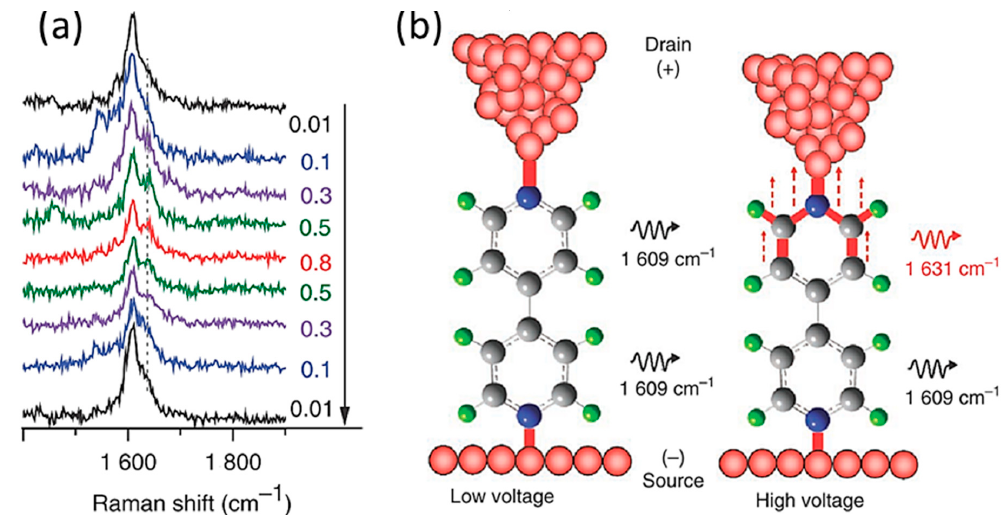
Figure 9. ( a ) The bias voltage dependence on TERS of BPY molecular junction featuring the ν 8a band (1610 cm − 1 ); ( b ) The schematic of the BPY single-molecular junction at a low and high bias-voltage ( λ ex : 632.8 nm, laser intensity: 5 mW) [33].